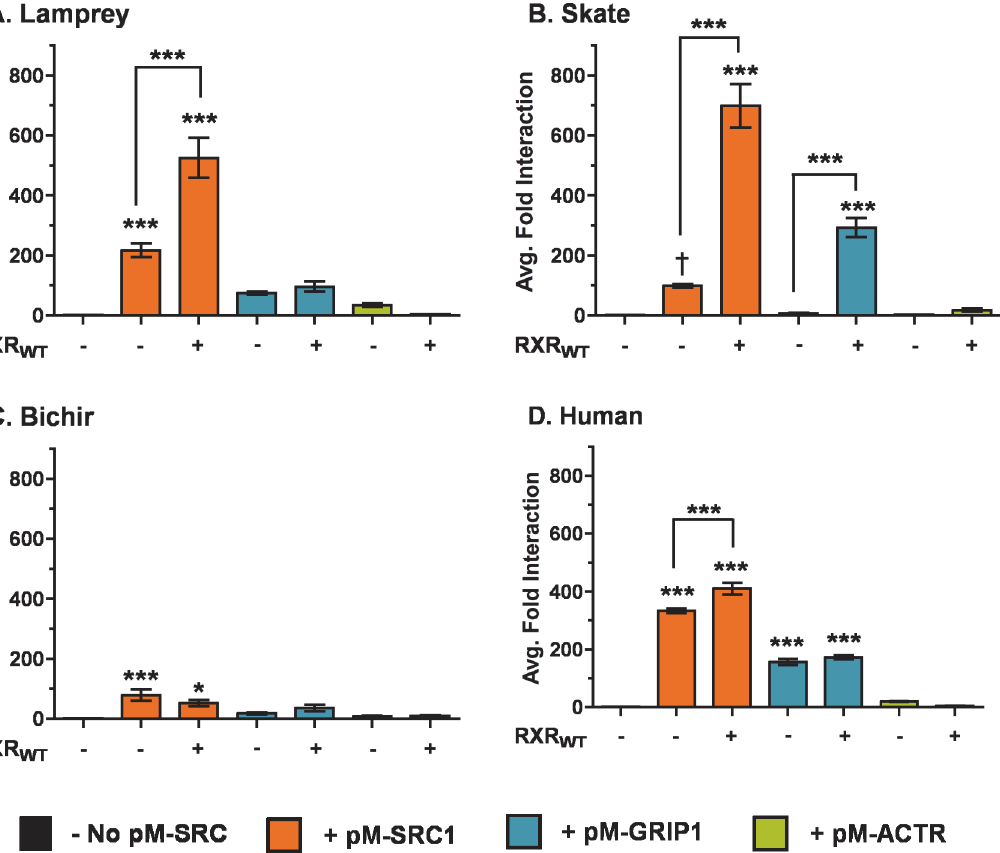
Fig 8. Mammalian 2-hybrid analysis of VDR interaction with SRC/p160 coactivators in response to 1, 25D 3 . The above graphs depict (A) lamprey VDR, (B) skate VDR, (C) bichir VDR, and (D) human VDR. Assays were conducted both in the presence (+) and absence (-) of pCDNA-RXR WT . HepG2 cells were transiently transfected with pVP16-VDR as prey and pM-SRC1 (orange bars), pM-GRIP1 (blue bars), or pM-ACTR (yellow bars) as bait, along with the 5XGal4-TATA-Luc reporter and pRL-CMV as an internal luciferase control. Cells were exposed to 120 nM 1, 25D 3 in media for 24 hours. Protein-protein interaction was measured via dual-luciferase assays as described in the Materials and Methods. Data are represented as the mean fold interaction ± SEM (n = 4). Data are normalized to VDR + empty pM vector (no coactivators). Asterisks above bars represent a significant interaction between VDR and the SRC/ p160 coactivators: *** = p < 0.001, ** = p < 0.01, * = p < 0.05. Asterisks above brackets indicate the addition of RXR WT significantly enhanced VDR-SRC/ p160 interaction. The interaction between pVP16-skate VDR and pM-SRC1 was tested with an unpaired t-test: t 6 = 16.56, p < 0.0001 ( † ).